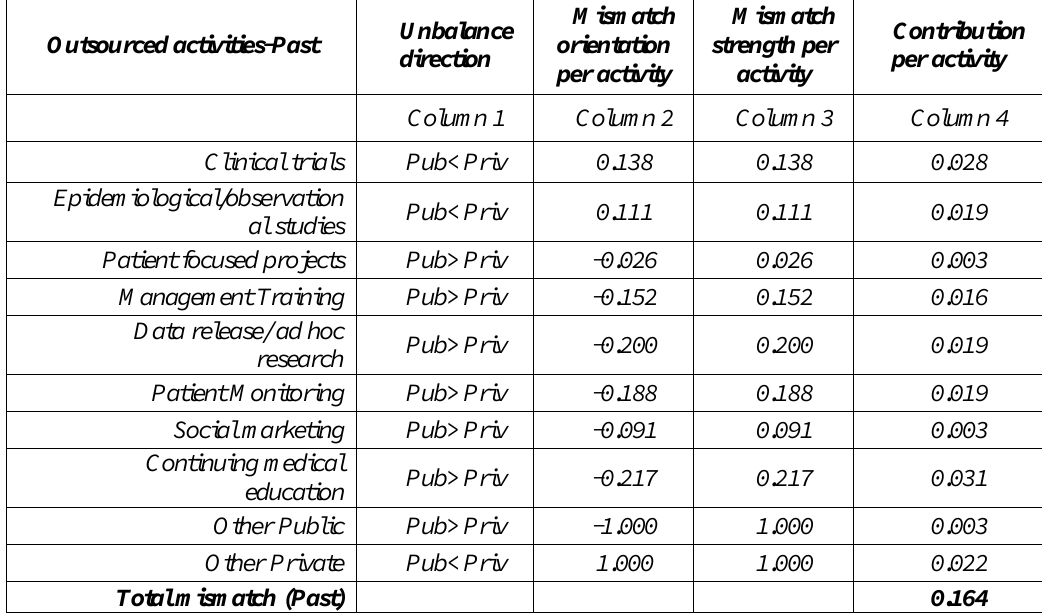
Table 1: Mismatch Value per Outsourced activities-Past Outsourced